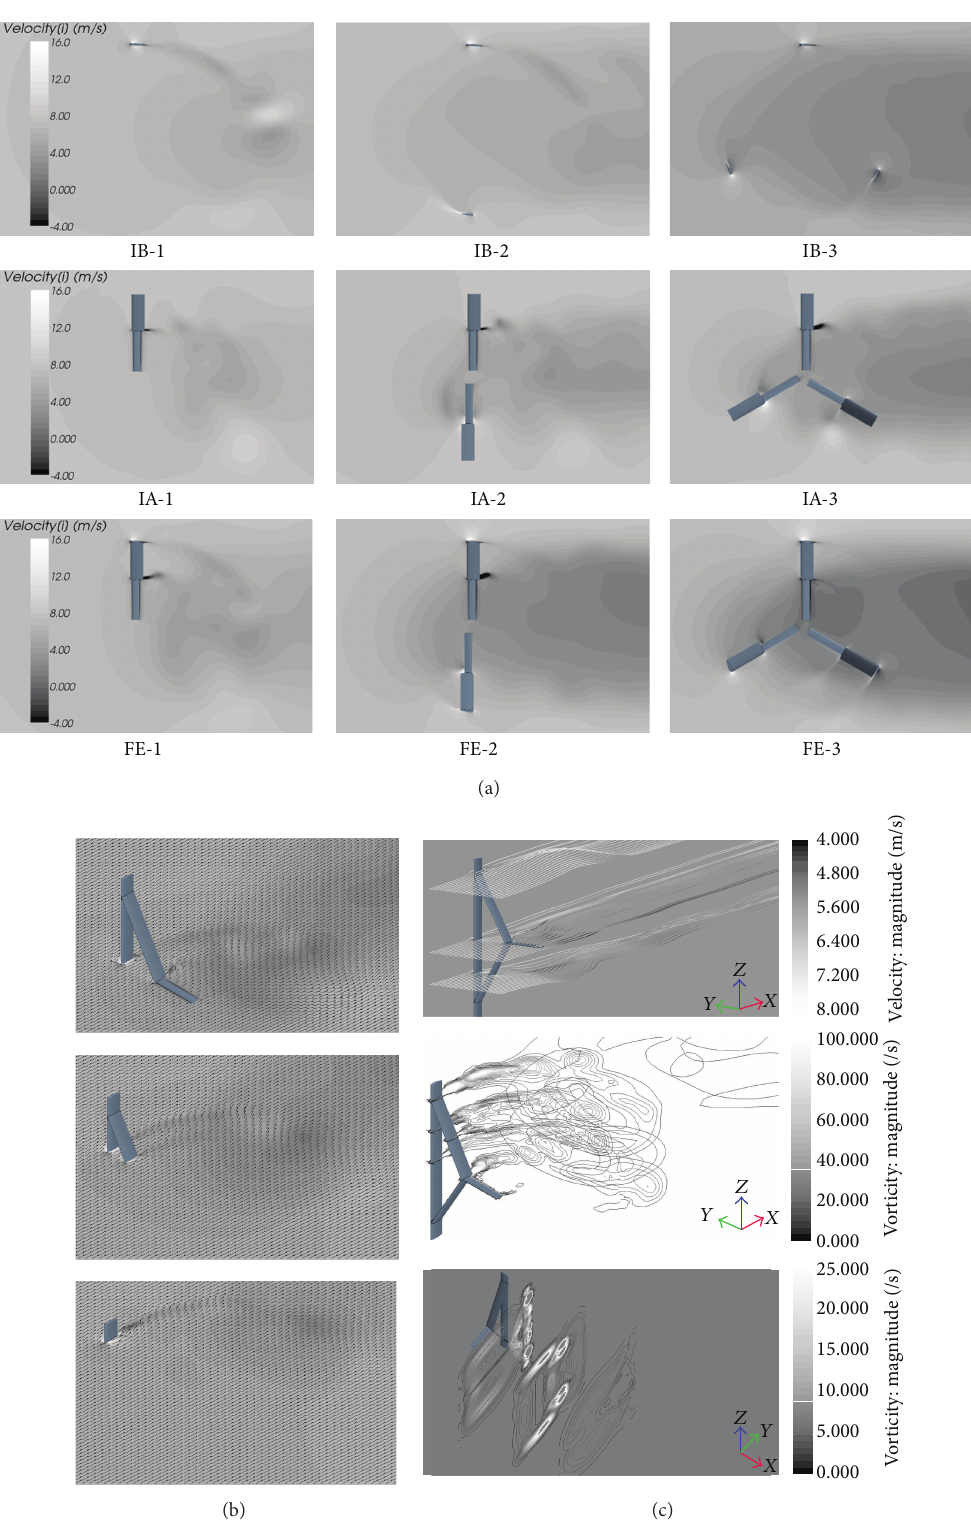
Figure 13: (a) Scalar fields of 𝑋 -velocity component, which has the same direction of the asymptotic wind velocity (wind blowing from left to right), taken at hub height. First row shows simulation results for one or multiple blades. Second row shows results for one or multiple arms. Third row shows results for one or multiple turbine elements. The blockage effect of the turbine is clearly seen, especially in the downwind zone, being enhanced as the number of elements grown. The local presence of reverse flow is also visible. (b) Velocity vector fields in a plane orthogonal to the turbine axis. (c) Streamlines (top) and vorticity magnitude maps in planes orthogonal to the turbine axis (middle) and in planes orthogonal to the free stream velocity, in the downwind zone